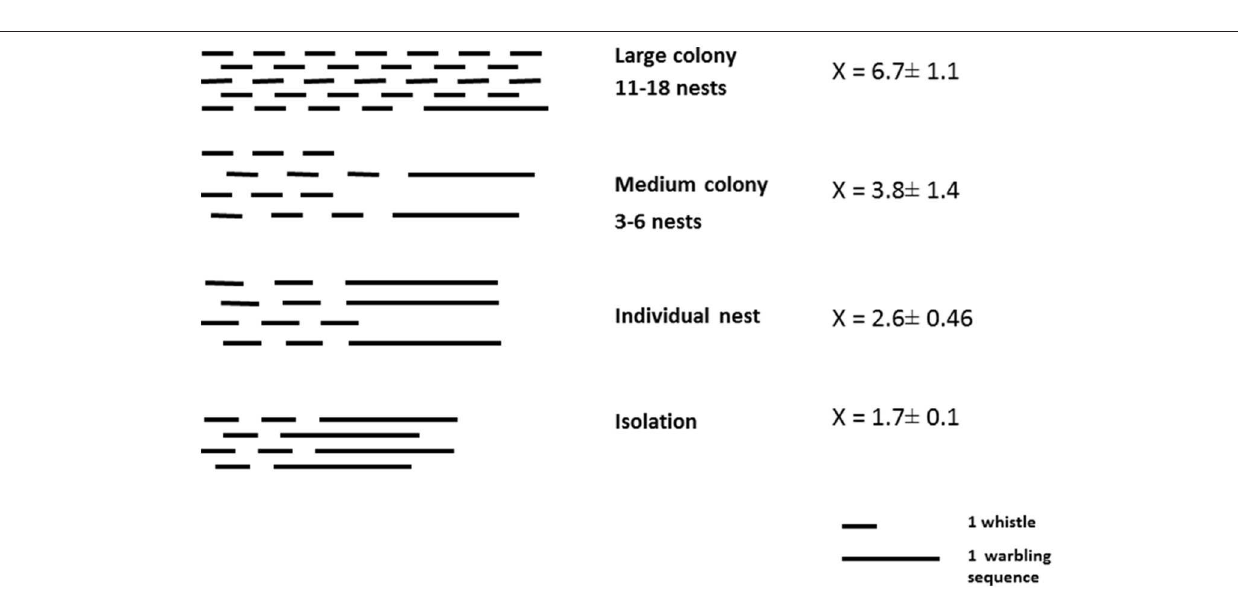
FIGURE 4 | Song style of birds belonging to colonies of different size. Although the birds were recorded in very different conditions, a clear trend appeared toward an increase in whistling (hence discontinuous songs) and a decrease of warbling (hence continuous song) with increasing colony size ( = number of neighbors) (From Hausberger,